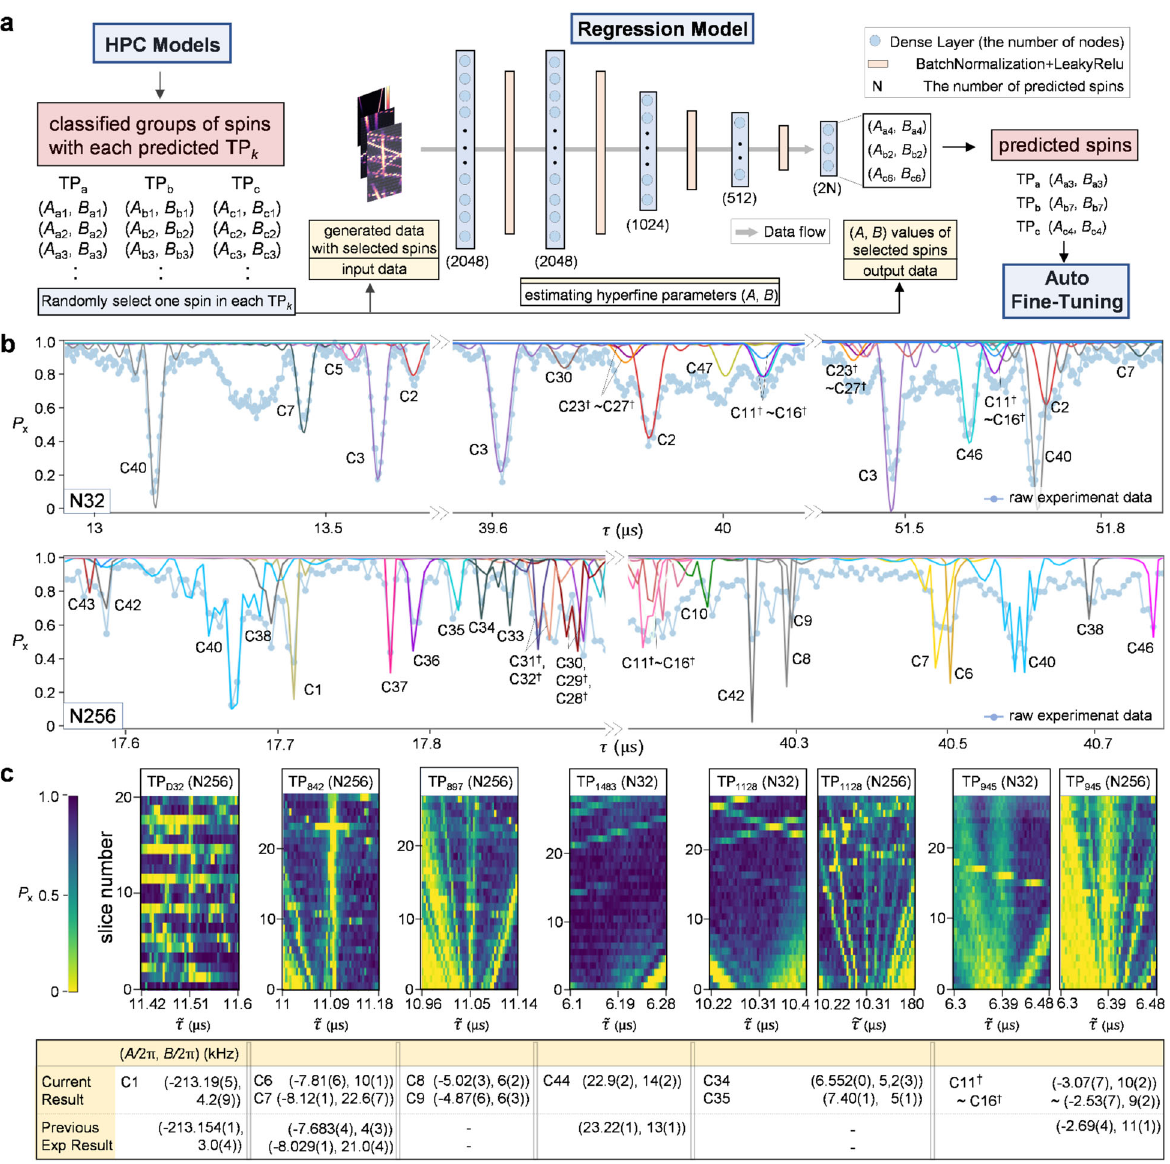
Fig. 4 Multiple nuclear spin detection from experimental data. a Procedures for a regression model estimating hyper fi ne parameters from predicted periods of HPC models. Training datasets of the regression model are generated using ( A , B ) pairs with the predicted periods by HPC models. The regression model infers the single ( A , B ) pair that best fi ts with the features of the experimental data (reorganized as 2D image) including coherence dip amplitudes, envelope function, and fringe patterns. b Multiple nuclear spin detection from the experimental CPMG data for N = 32 (top panel) and N = 256 (bottom panel) using the same NV center. The panels show superimposed reproduced CPMG signal (solid curves) and the experimental data (dotted curve). The spin numbers (C# or C# † ) indicated in the fi gure corresponds to the full spin list summarized in Supplementary Table 2. c Con fi rmation of detected hyper fi ne parameters for spins with a large number of interfering signatures (1st panel), similar target periods (2nd and 3rd panels), weak local period signature (4th panel), small transverse hyper fi ne coupling (5 th panel), and small longitudinal hyper fi ne coupling (6th panel). We compare the obtained values to the results reported in ref. 19 (bottom row, see main text). The panels also show examples of spins with small A that were not detected in ref. 19 (3rd, 5th, and 6th panels). The uncertainty in the last digit is given in parentheses. The color scale bar in all 2D images ranges from 0 to